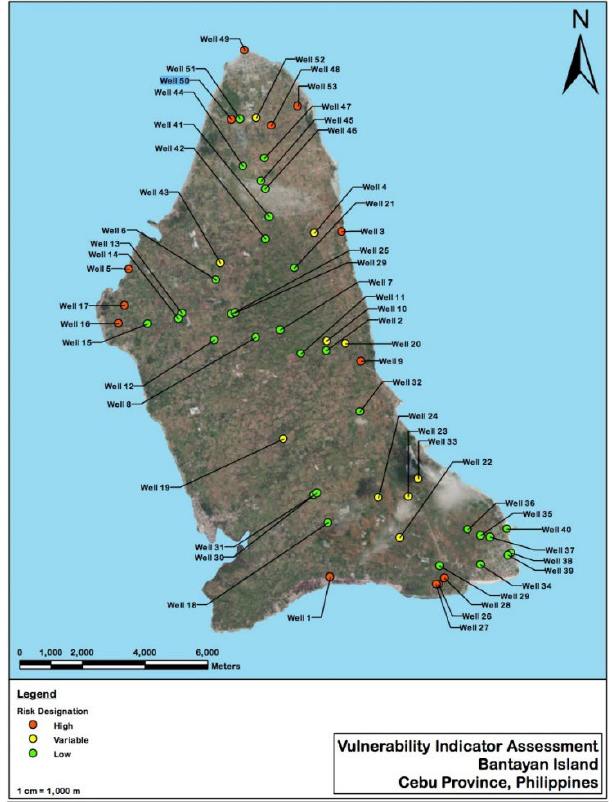
Figure 6. Vulnerability Indicator Assessment Map, Bantayan Island, Cebu Province, Philippines [15].